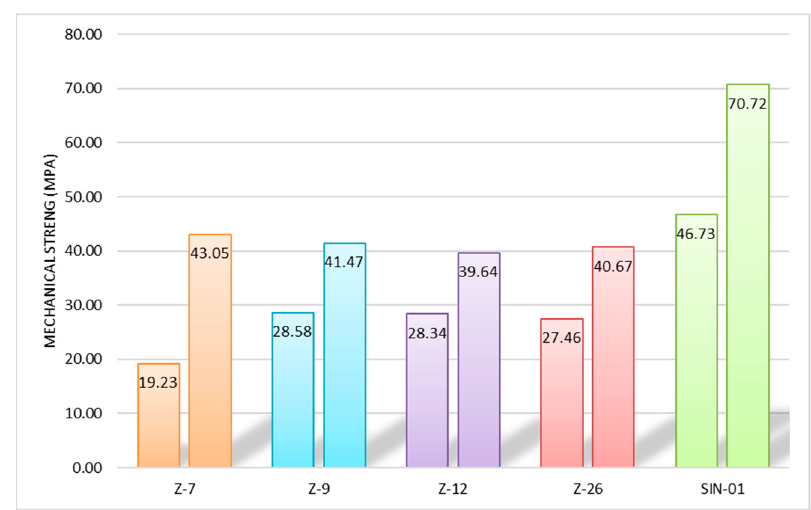
Figure 8. Results of mechanical resistance of the specimens at age of 7 and 28 days. Table 4. Results of setting time of the